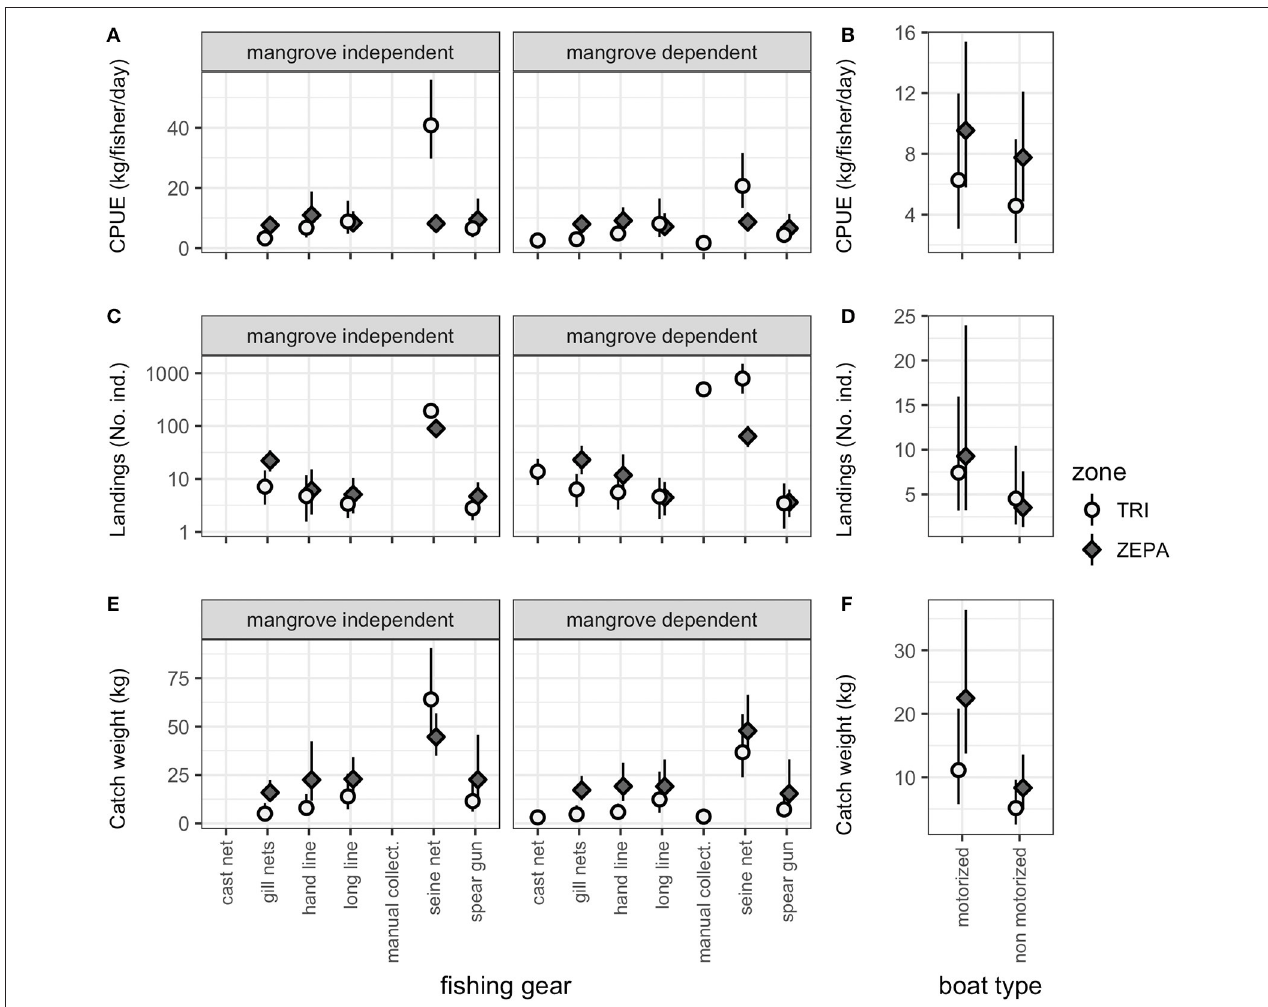
FIGURE 5 | Predicted mean values from linear mixed effects models across management zone, fishing method, and species mangrove dependence for (A) CPUE (kg/fisher/day), (C) number of individuals landed, and (E) catch weight landed (kg). Predicted mean values are also presented across management zone and boat type for (B) CPUE (kg/fisher/day), (D) number of individuals landed, and (F) catch weight landed (kg). Data shows trends for fisheries landings collected between 2010 and 2013 from the Exclusive Zone of Artisanal Fishing (ZEPA) (grey diamonds) and the Gulf of Tribugá (white circles), Colombia. Number of individuals landed is given on a log scale. Vertical lines represent confidence intervals and are asymmetrical because data was modelled using log-normal distributions back transformed to a linear scale for representation. Thus, confidence intervals are symmetric in the logarithmic space but appear asymmetric in a linear